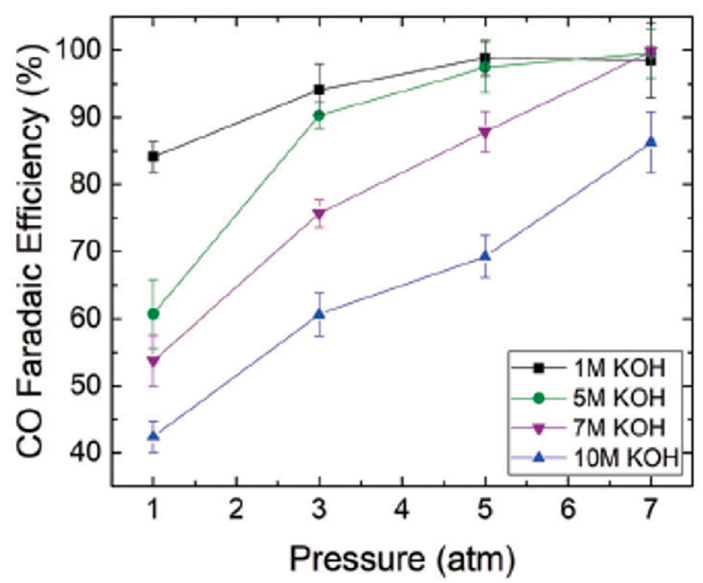
Figure 14. The effect of cell pressure on CO Faradaic efficiency and electrolyte concentrations at an operating condition of 300 mA cm − 2 . Reprinted with permission from the authors of [23].